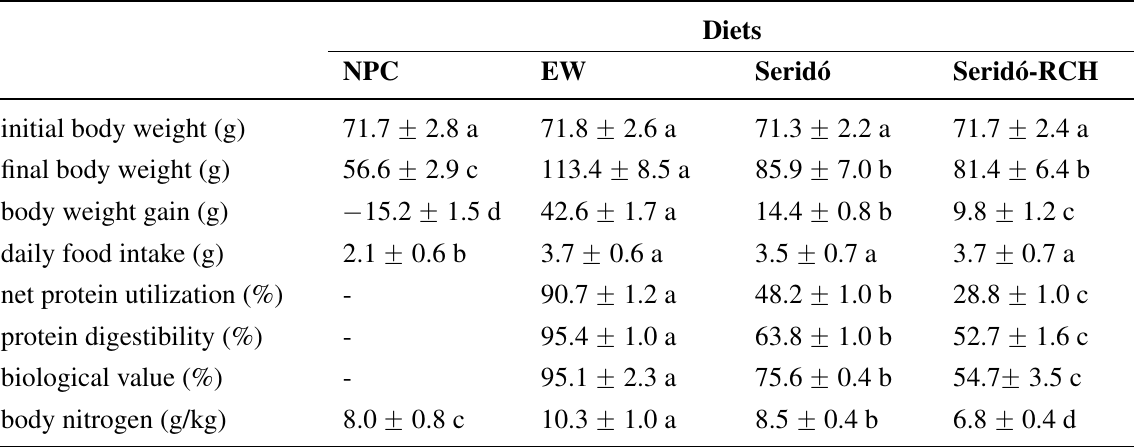
Table 4. Nutritional parameters of rats fed on Seridó and Seridó-RCH seed-based defatted flours compared with those of rats fed on egg white (EW) and non-protein control (NPC) diets